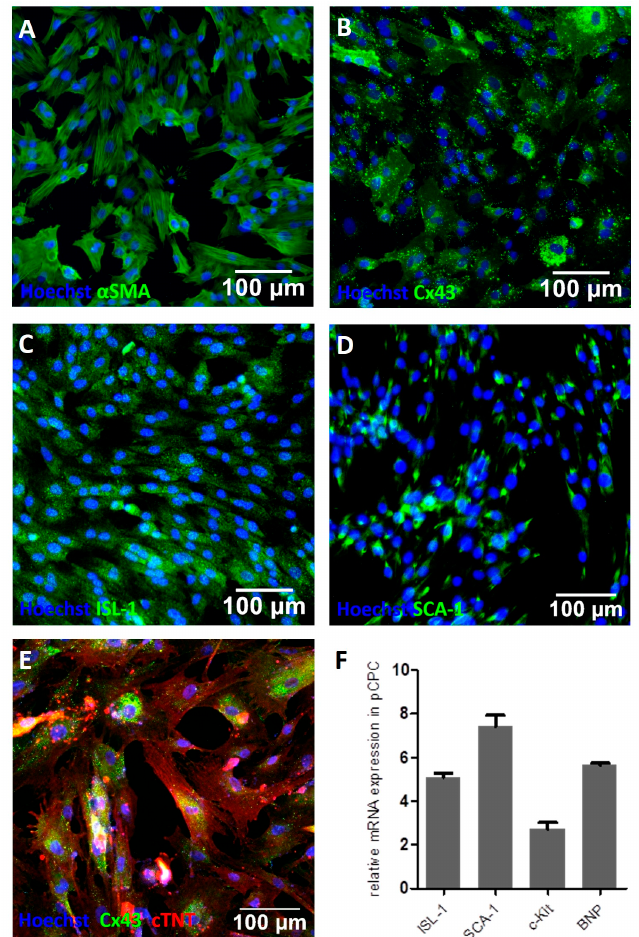
Figure 2. Characterization of pCPCs. Immunofluorescence staining revealed the presence of proteins associated with the cardiac cell lineage such as ( A ) α SMA, ( B ) Cx43, and ( E ) cTNT (depicted in red). Cardiac progenitor cell associated markers like ( C ) Isl-1 and ( D ) Sca-1 stained positive. ( F ) Relative gene expression further proved the presence of genes encoding for Isl-1, Sca-1, c-kit, and BNP.